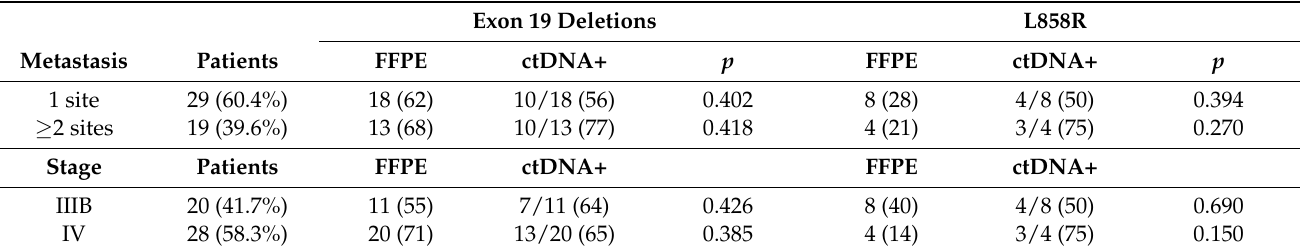
Table 3. EGFR mutation status on primary tumour tissue and blood ctDNA at progression according to the disease Table 2. EGFR mutation status comparison between testing on primary tumour tissue with py- rosequencing and on blood ctDNA at progression with Therascreen.